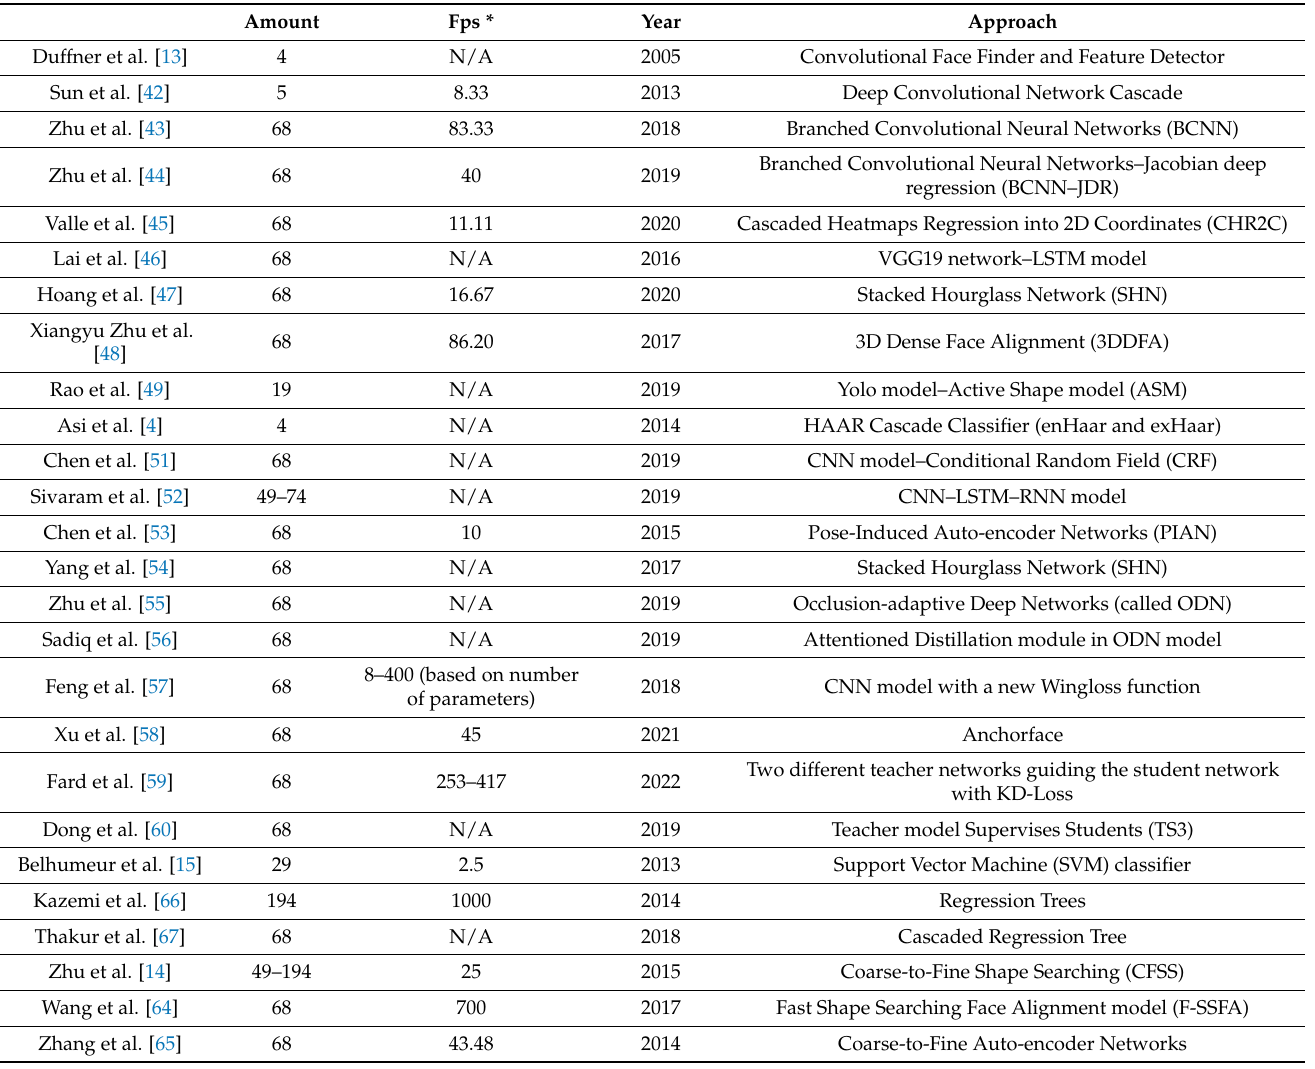
Table 2. Summarizing the facial landmark extraction using deep CNN and non-deep CNN models, reviewed in Sections 3.1 and